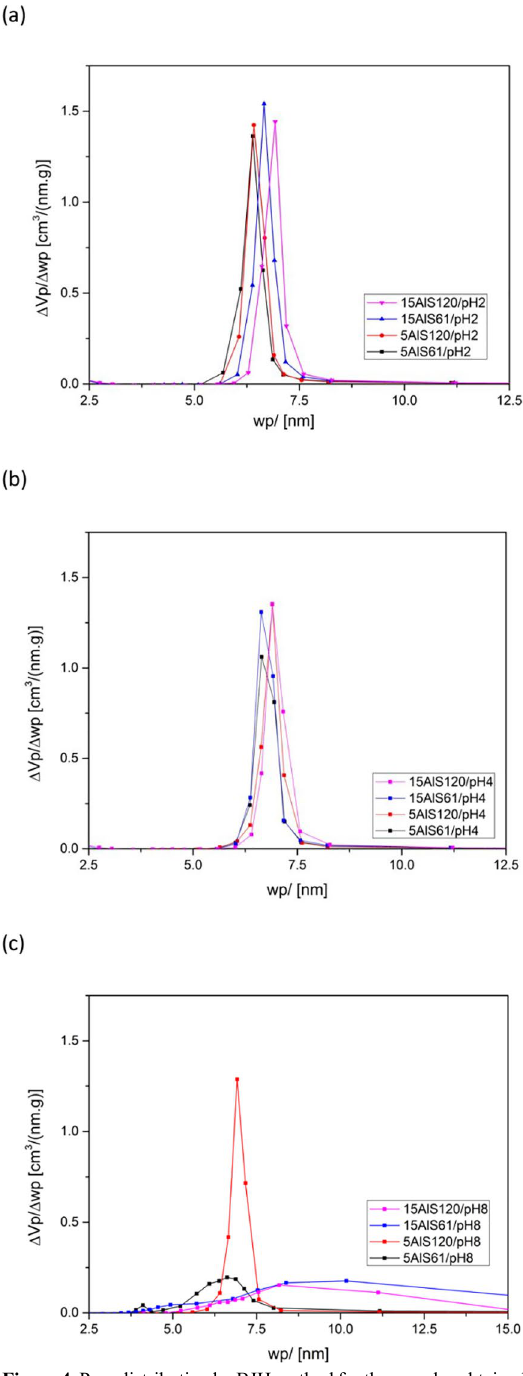
Figure 4. Pore distribution by BJH method for the samples obtained by synthesis with pH adjustment: (a) pH=2.0; (b) pH = 4.0 and (c) pH = The 27 Al MAS NMR spectra of all samples analyzed show two peaks at approximately 50 ppm and 0 ppm (Figure 5). Signals in these regions are due to the presence of Al tetrahedrally coordinated (Al IV) and Al hexacoordinated (Al VI), respectively 7,16 . Figure 5 (a) and (b) refer to the